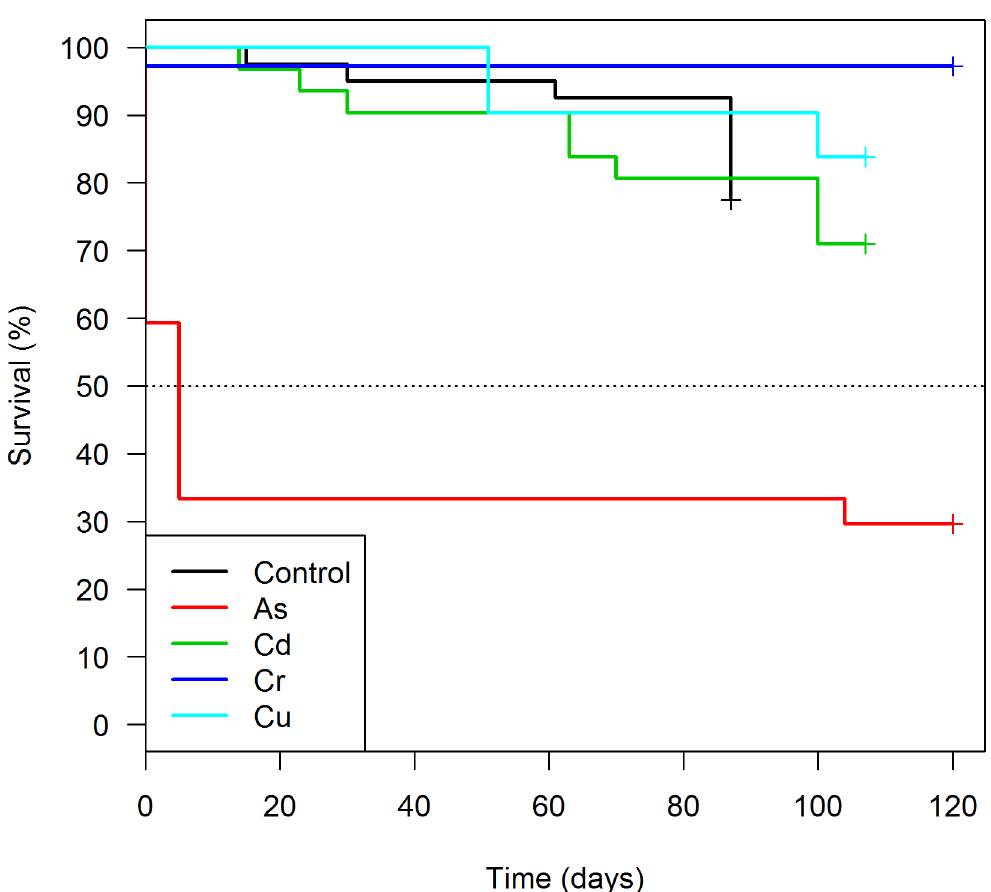
Fig 1. Survival analysis of Triatoma brasiliensis fed with sheep blood enriched with one of the following trace elements: As (N = 27), Cd (N = 31), Cr (N = 36), Cu (N = 31) and control group (N = 40).